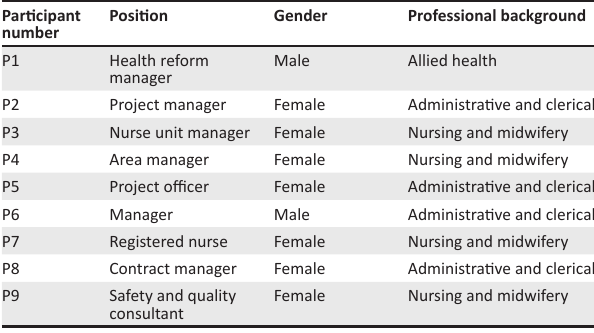
TABLE 4: Interview participant details.